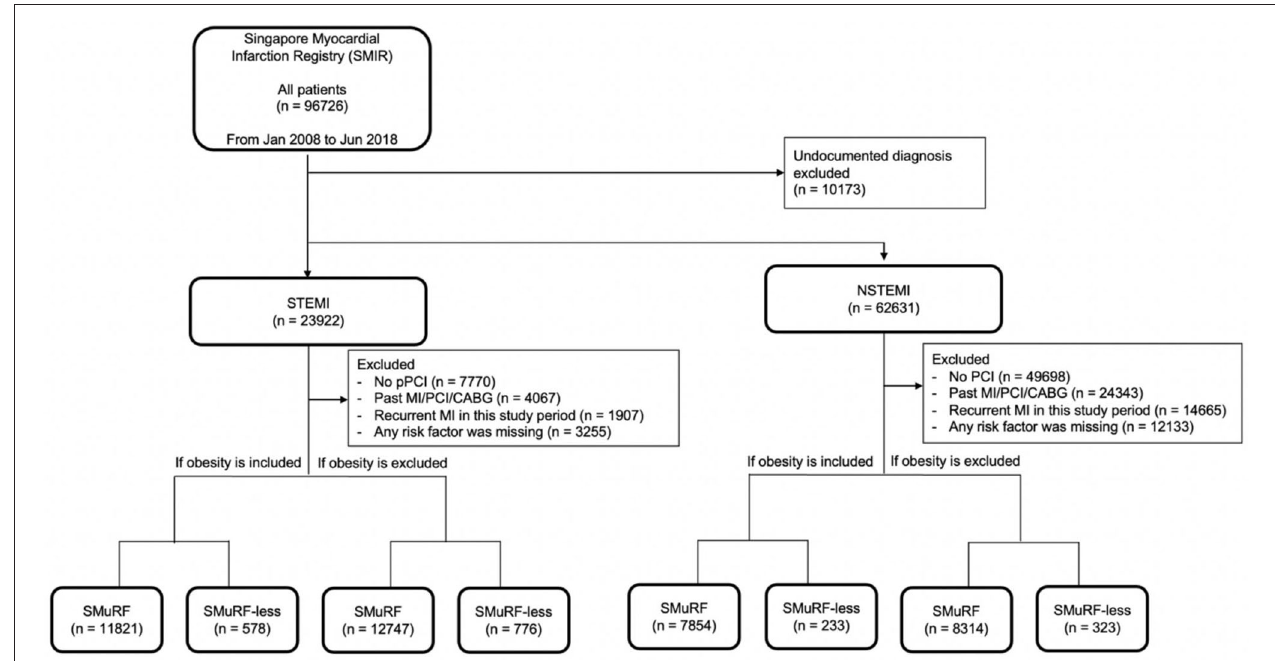
FIGURE 1 | Flowchart of data inclusion. The following criteria for exclusion were applied in this selection: (1) undocumented diagnosis, (2) no percutaneous intervention (PCI) performed, (3) past MI/PCI/coronary arterial bypass surgery (CABG), (4) recurrent MI in this study period, and (5) any risk factor missing. For both STEMI and NSTEMI, obesity was included or excluded to evaluate the impact of obesity as a risk factor in AMI.